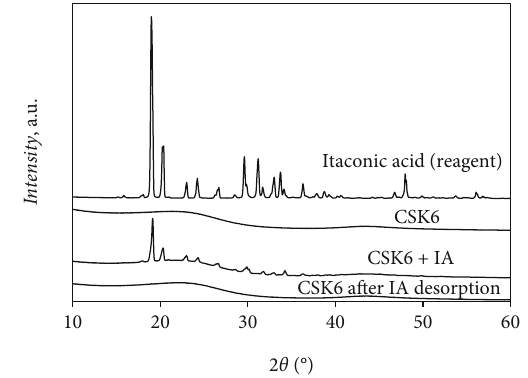
Figure 8: X-ray di ff raction patterns of the CSK6 adsorbent with and without adsorbed IA and after its